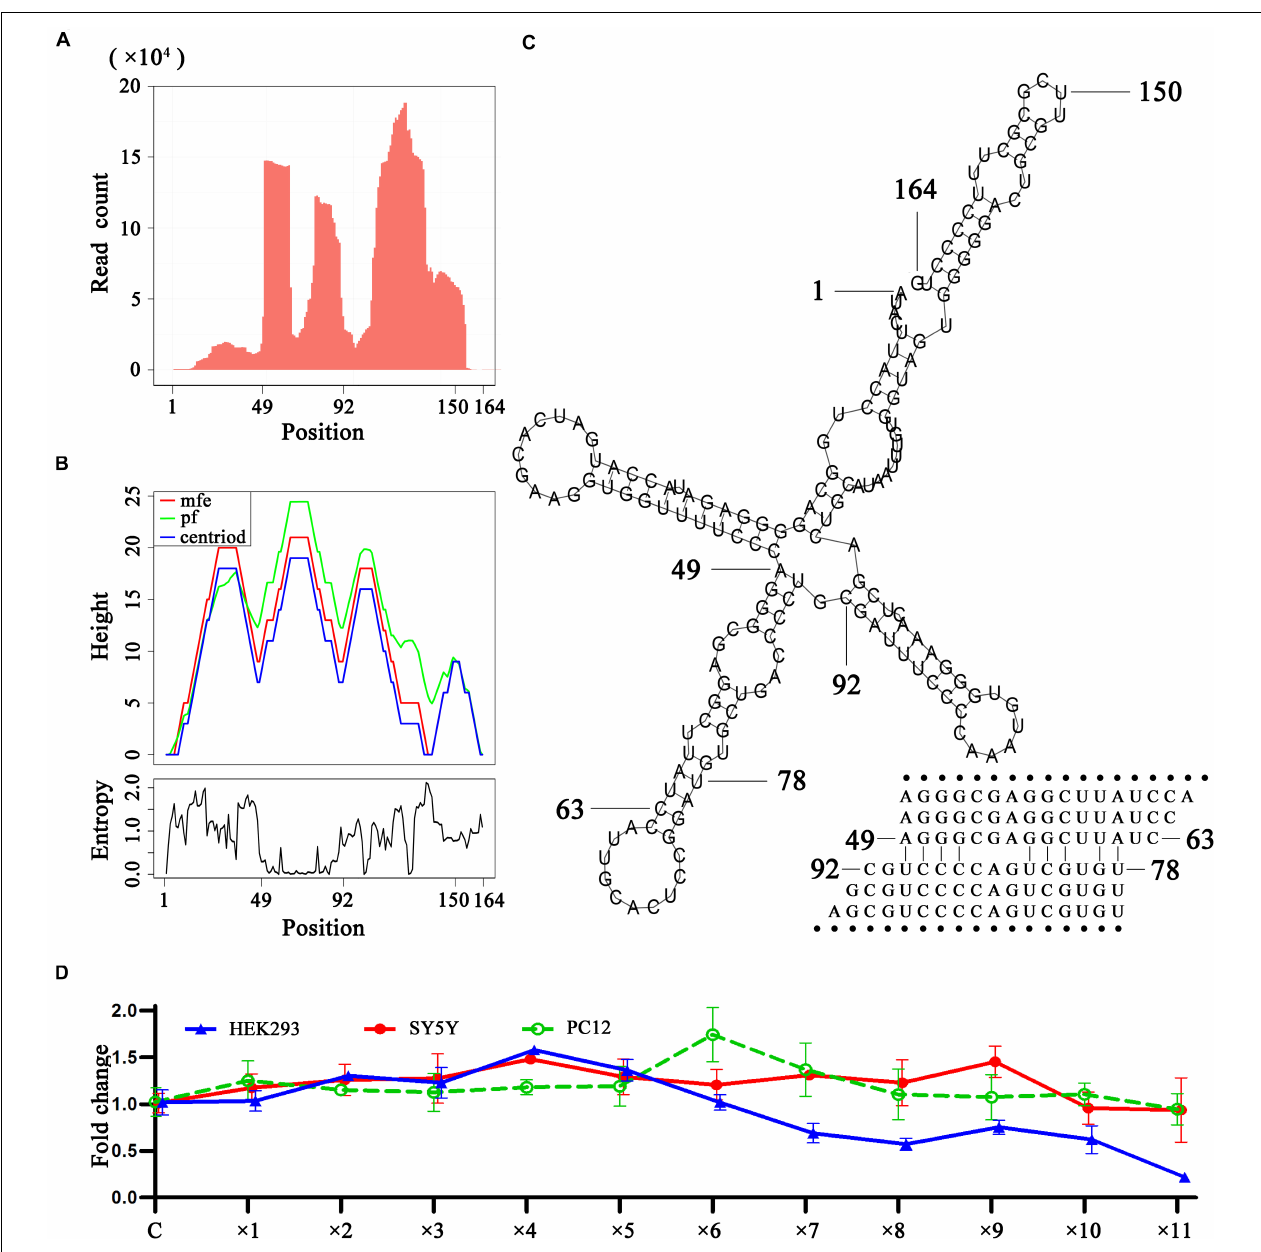
FIGURE 4 | SiRNA duplexes discovered from U1 snRNAs. (A) The count distribution of all aligned reads on the reference U1 snRNA (RefSeq: NR_004430.2). (B) The above is a mountain plot representation of the MFE structure, the thermodynamic ensemble of RNA structures and the centroid structure. The positional entropy for each position is showed below. (C) The secondary structure of U1 snRNA. (D) U1 over-expression in the HEK293 (human), SY5Y (human) and PC-12 (rat) cell lines were conducted by virus transfection. The qPCR results showed the relative expression levels of U1 in 12 groups. For each experiment, 12 groups of samples named control, × 1, × 2, × 3, × 4, × 5, × 6, × 7, × 8, × 9, × 10, and × 11 were transfected by 0, 1, 2, 3, 4, 5, 6, 7, 8, 9, 10, and 11 µ L U1-packaged lentiviruses The control group used unprocessed